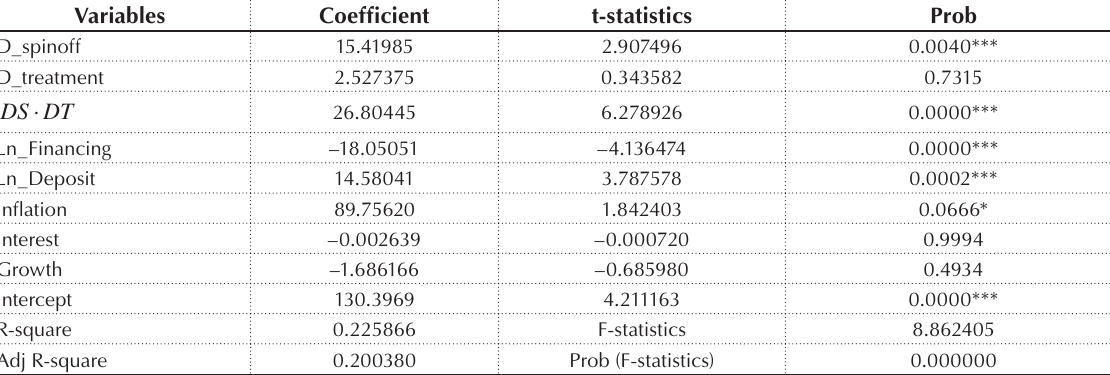
Table 3. (cid:28)(cid:400)(cid:415)(cid:373)(cid:258)(cid:415)(cid:381)(cid:374)(cid:3)(cid:396)(cid:286)(cid:400)(cid:437)(cid:367)(cid:410)(cid:400)(cid:3)(cid:381)(cid:296)(cid:3)(cid:400)(cid:393)(cid:349)(cid:374)(cid:882)(cid:381)(cid:299)(cid:3)(cid:258)(cid:374)(cid:282)(cid:3)(cid:393)(cid:286)(cid:396)(cid:296)(cid:381)(cid:396)(cid:373)(cid:258)(cid:374)(cid:272)(cid:286) Variables